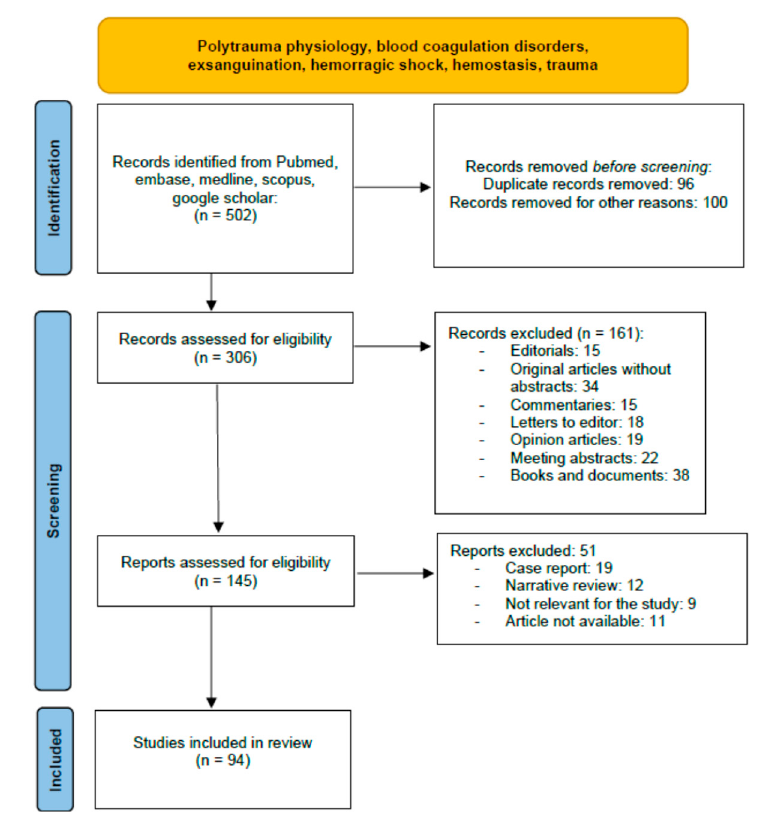
Figure 2. Virchow’s triad that interfere with the clinical